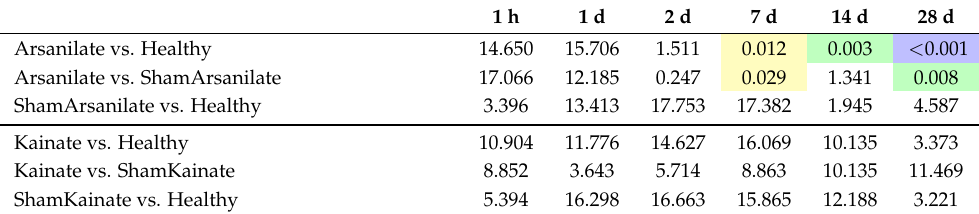
Table A7. Bonferroni-corrected p values for number of circles per minute (one-sided Mann–Whitney U test; p values lower than 0.05, 0.01 and 0.001 are highlighted in yellow, green and blue, respectively). 1 h